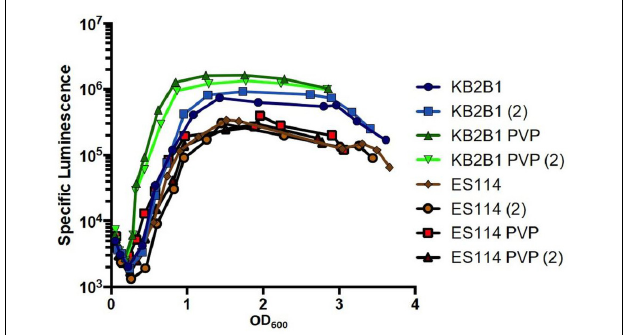
FIGURE 11 | Impact of polyvinylpyrrolidone (PVP) addition on luminescence of Vibrio fischeri . Levels of specific luminescence (relative light units divided by optical density) graphed vs. optical density (OD 600 ) of KB2B1 and ES114 grown in the absence and presence of 3.5% PVP. Luminescence experiments were performed with duplicate